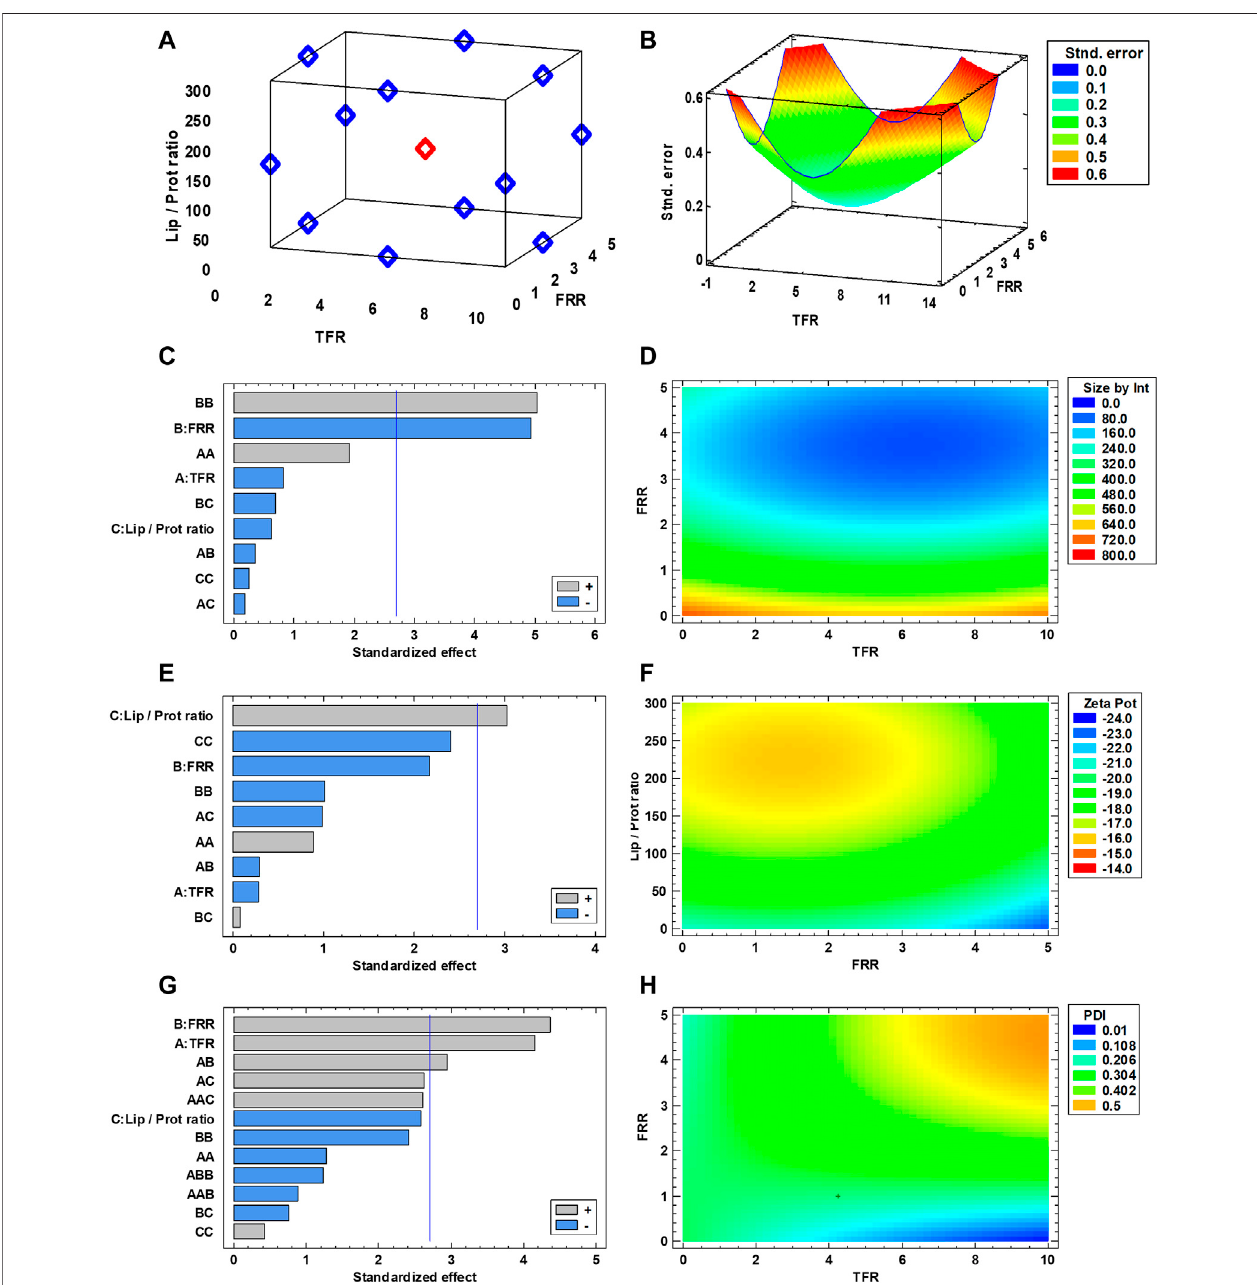
FIGURE1|(A) SchematicrepresentationoftheDoEusedforLeukooptimization. (B) AnalysisofvarianceusedfortheDoE. (C,E,G) StandardizedParetoChartfor statistical signi fi cance of the experimental parameters, red lines represent p = 0.01. (D,F,H) Response surfaces fi tted for each analyzed response ( n = 3 for all the performed